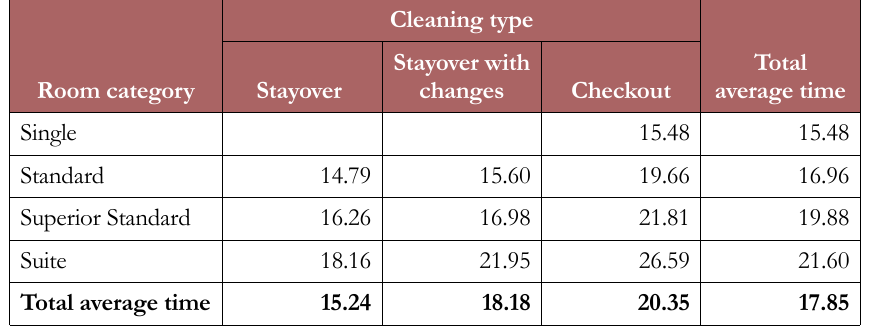
Table 5. Average total times in minutes without extras by cleaning and room type